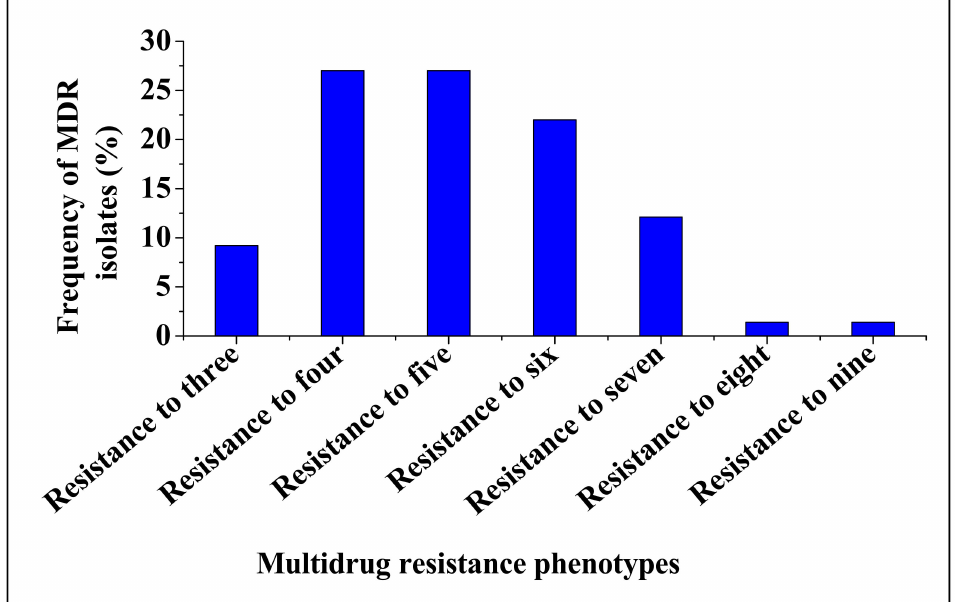
Figure 3. Frequency of multidrug resistance pattern in CRE isolated from cattle